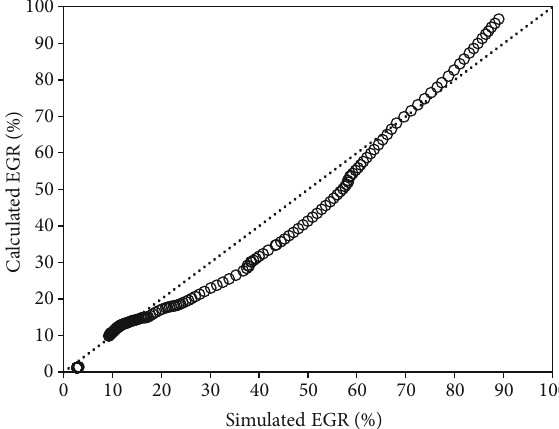
Figure 7: Gas saturation pro fi le of enriched gas fl